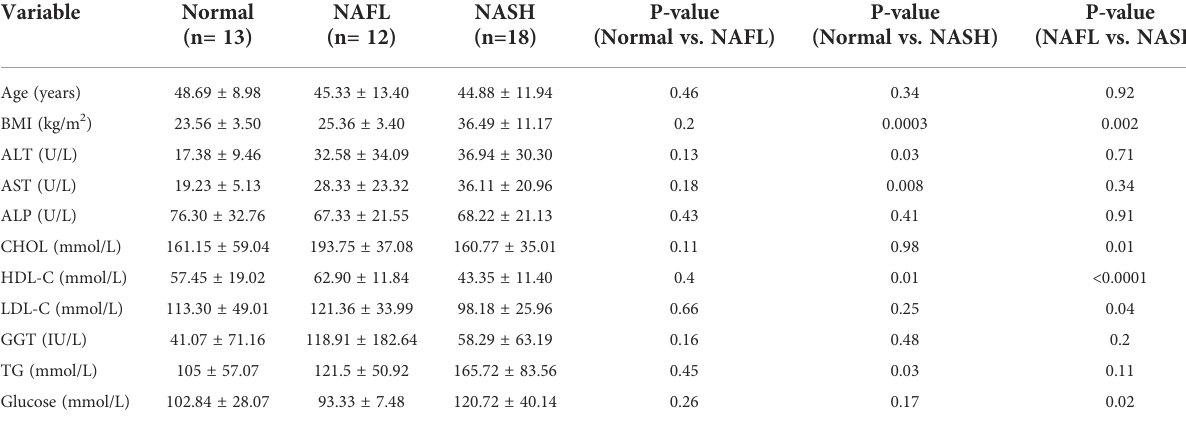
TABLE 1 Clinical characteristics of the patients (RNA sequencing).